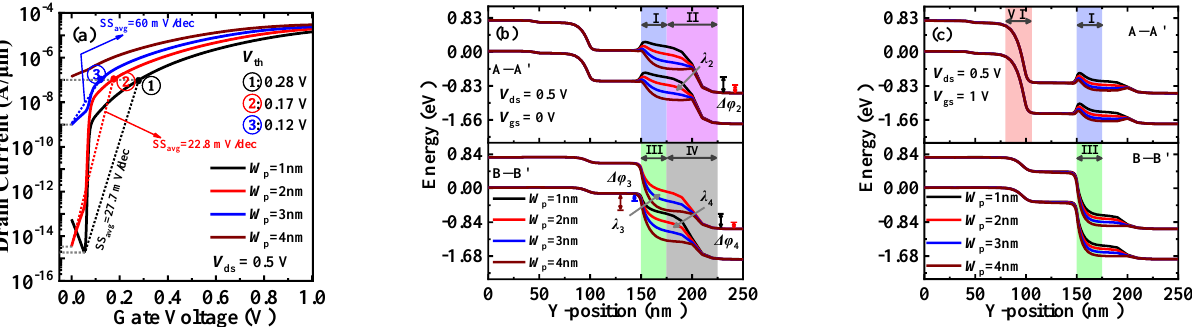
Figure 7. ( a ) Transfer characteristics; ( b ) energy band profiles along A–A’ and B–B’ in the OFF- and ( c ) energy band profiles along A –A’ and B–B’ in the ON -state, for DGNP-EHBTFET with W p = state; and ( c ) energy band profiles along A–A’ and B–B’ in the ON-state, for DGNP-EHBTFET with 1~4 nm. W p = 1~4